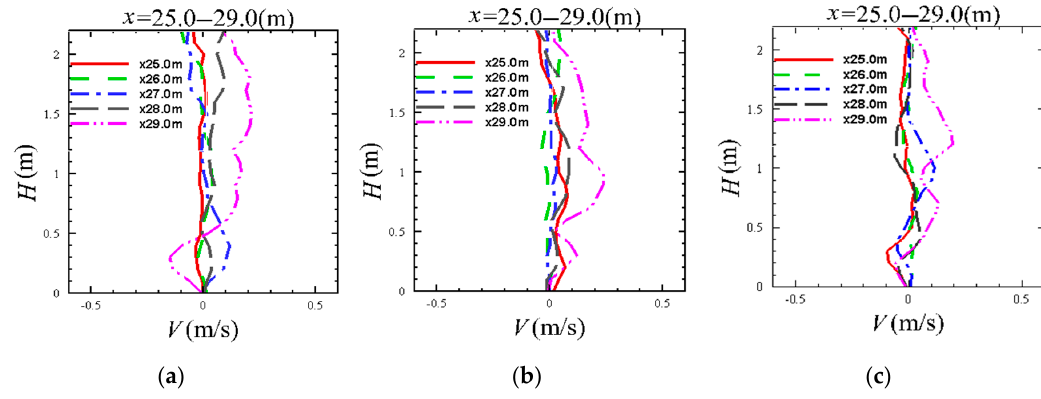
0.25, and 0.125 and x = 31.0–36.0 m. ( a ) n w = 0.5; ( b ) n w = 0.25; ( c ) n w = 0.125.